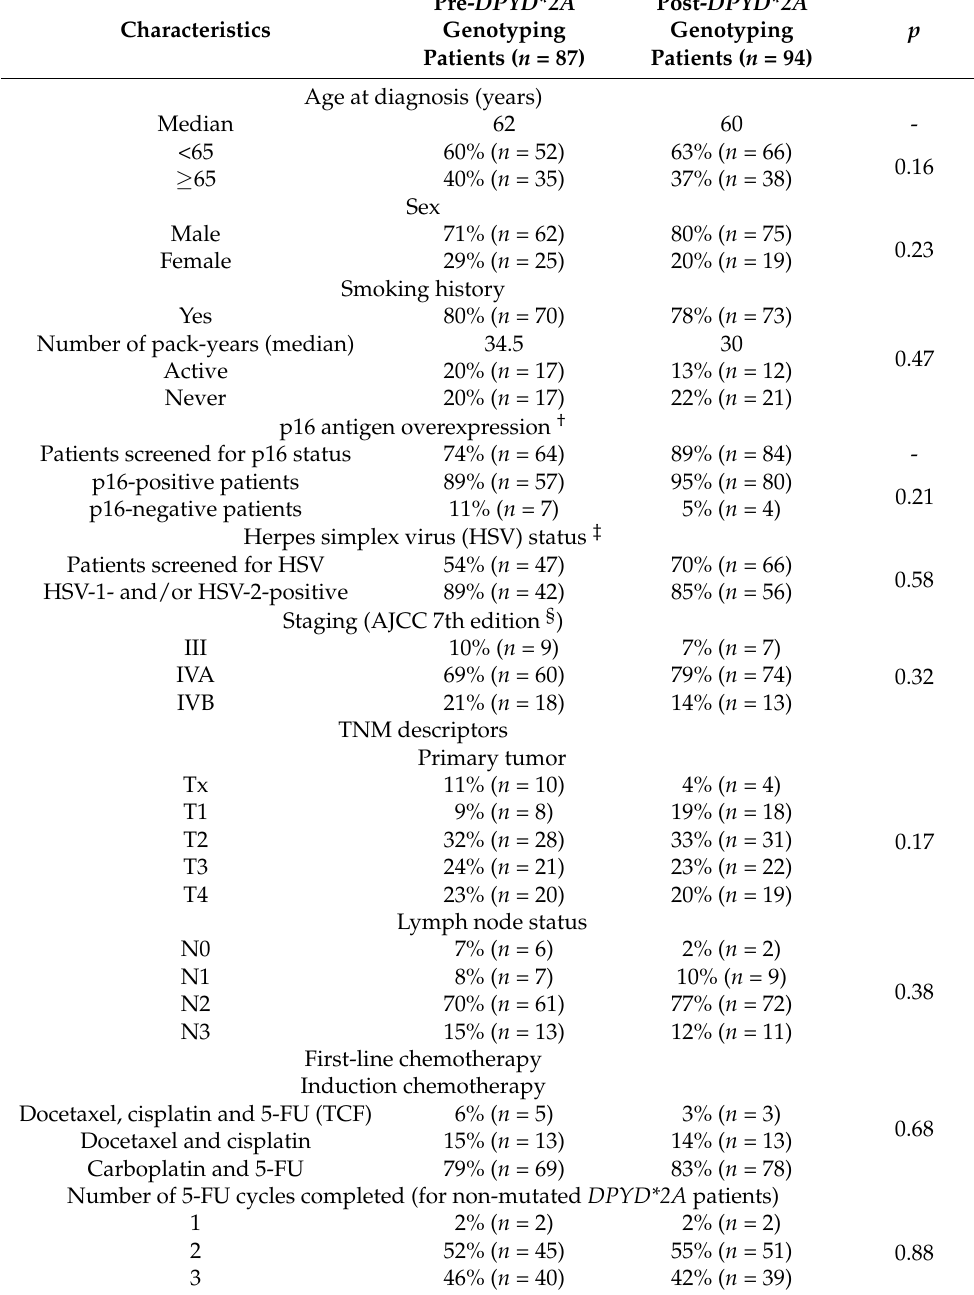
Table 1. Baseline